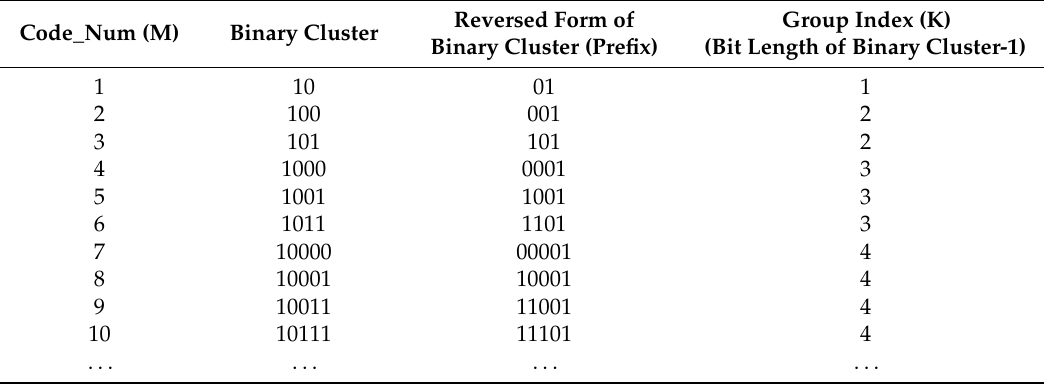
Table 1. Binary cluster patterns from the proposed and unary code